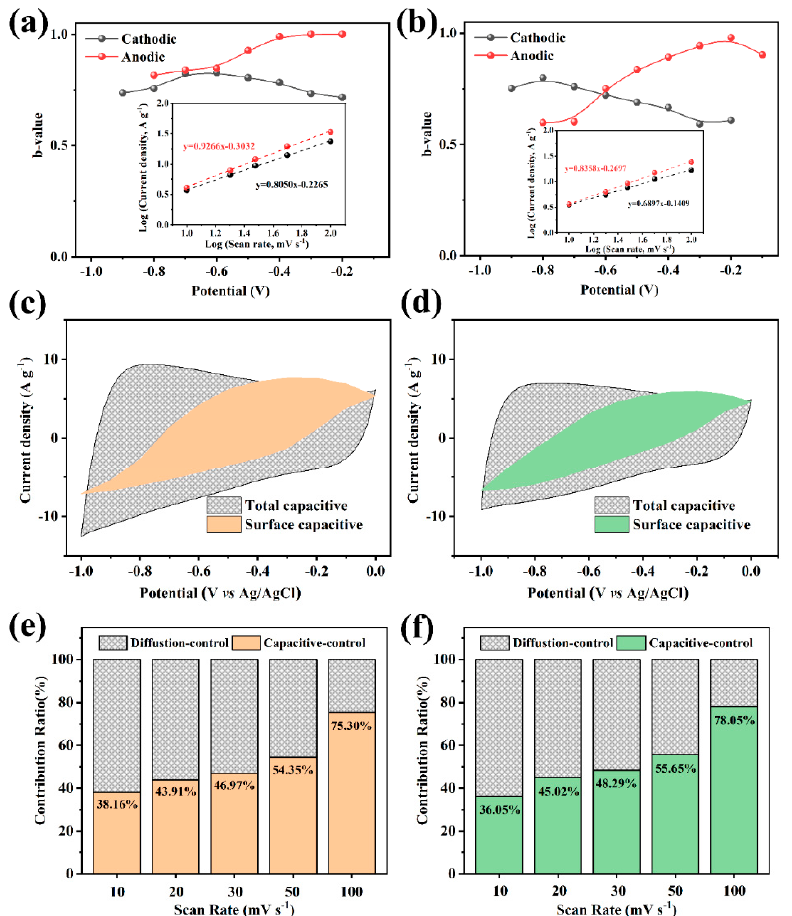
Figure 5. Calculated b -values of FPC-90 ( a ) and FPC-180 ( b ) from cathode and anode branch of CV curves, insets are the currents vs. scan rate plots of two electrodes derived from the CV curves of 20 mV s −− 1 at a potential of 0.5 V. The charge storage contributions of FPC-90 ( c ) and FPC-180 ( d ) from the pseudo-capacitance and EDLC at a scan rate of 20 mV s −− 1 . Ratio of capacitance contributions in FPC-90 ( e ) and FPC-180 ( f ) at different scan rates.